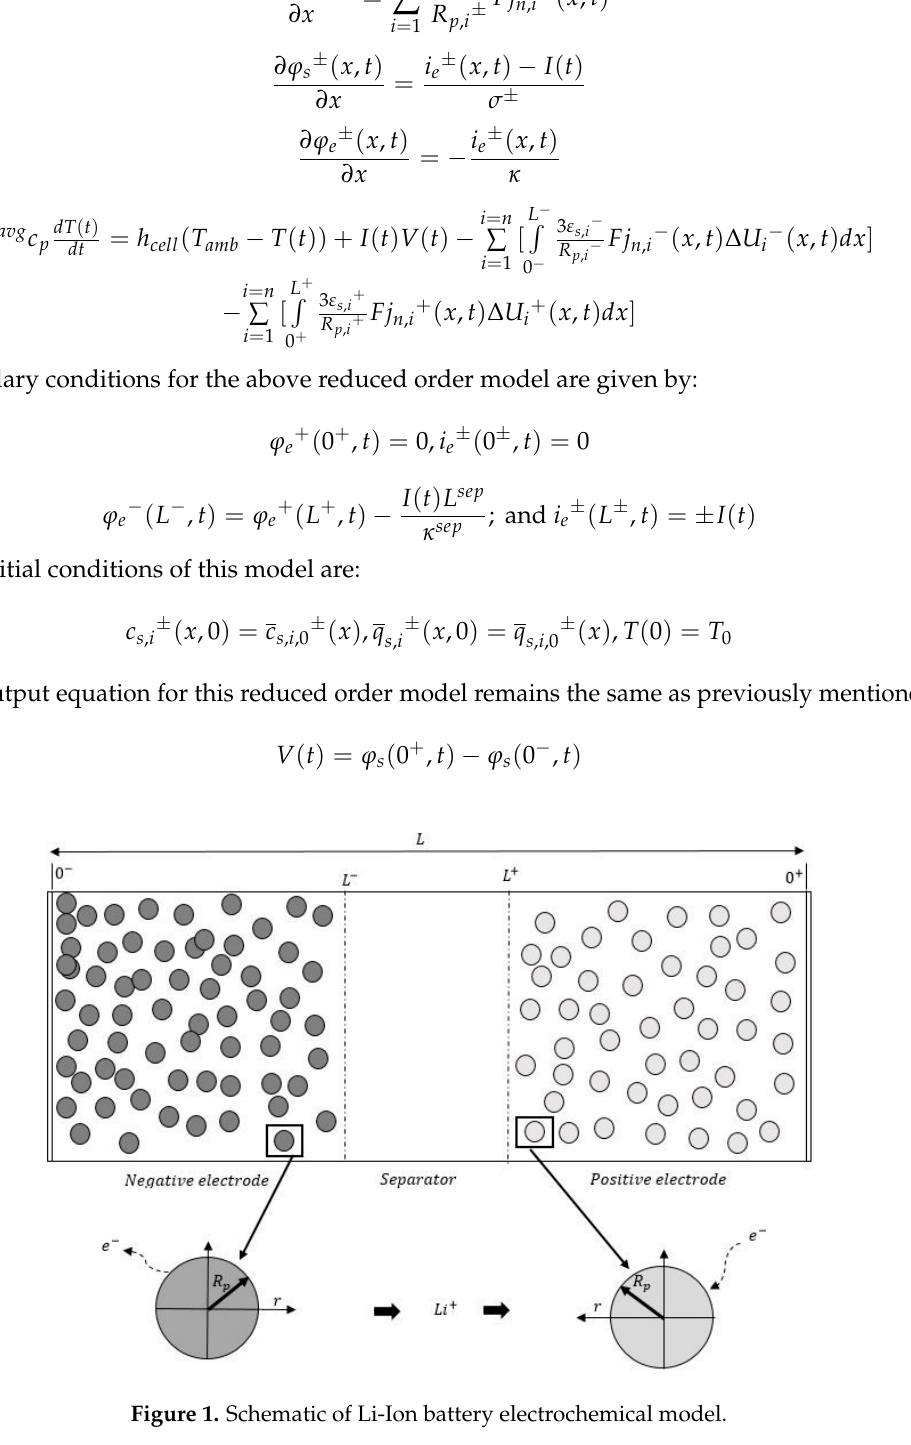
Figure 1. Schematic of Li-Ion battery electrochemical model.